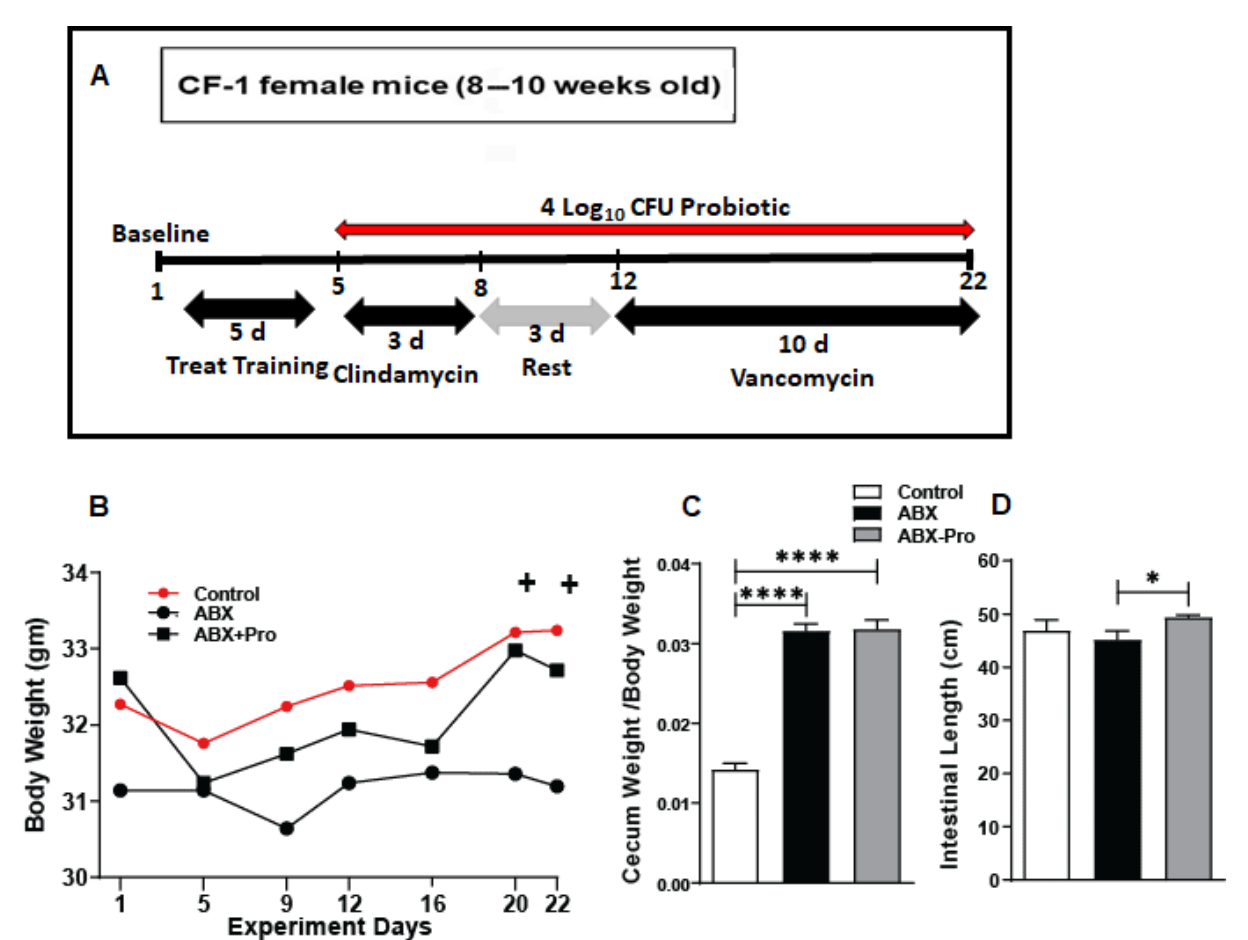
Figure 1. Mouse model and its tolerance. ( A ) Mice were treated with the probiotic blend starting on day five until study end. To induce gut dysbiosis, starting on day five animals were treated with clindamycin for 3 days; control mice received saline. Beginning on day 12, mice were treated with either vancomycin or saline for 10 days, after which they were euthanized on day 22 and intestine was dissected. ( B ) Mice were weighed at specific time points and compared. ( C ) Cecum was weighed and compared to mouse body weight. ( D ) Intestinal length from proximal duodenum to rectum was measured and compared. Values represent mean ± standard error of the mean. + p = 0.06, * p < 0.05, **** p < 0.0001.